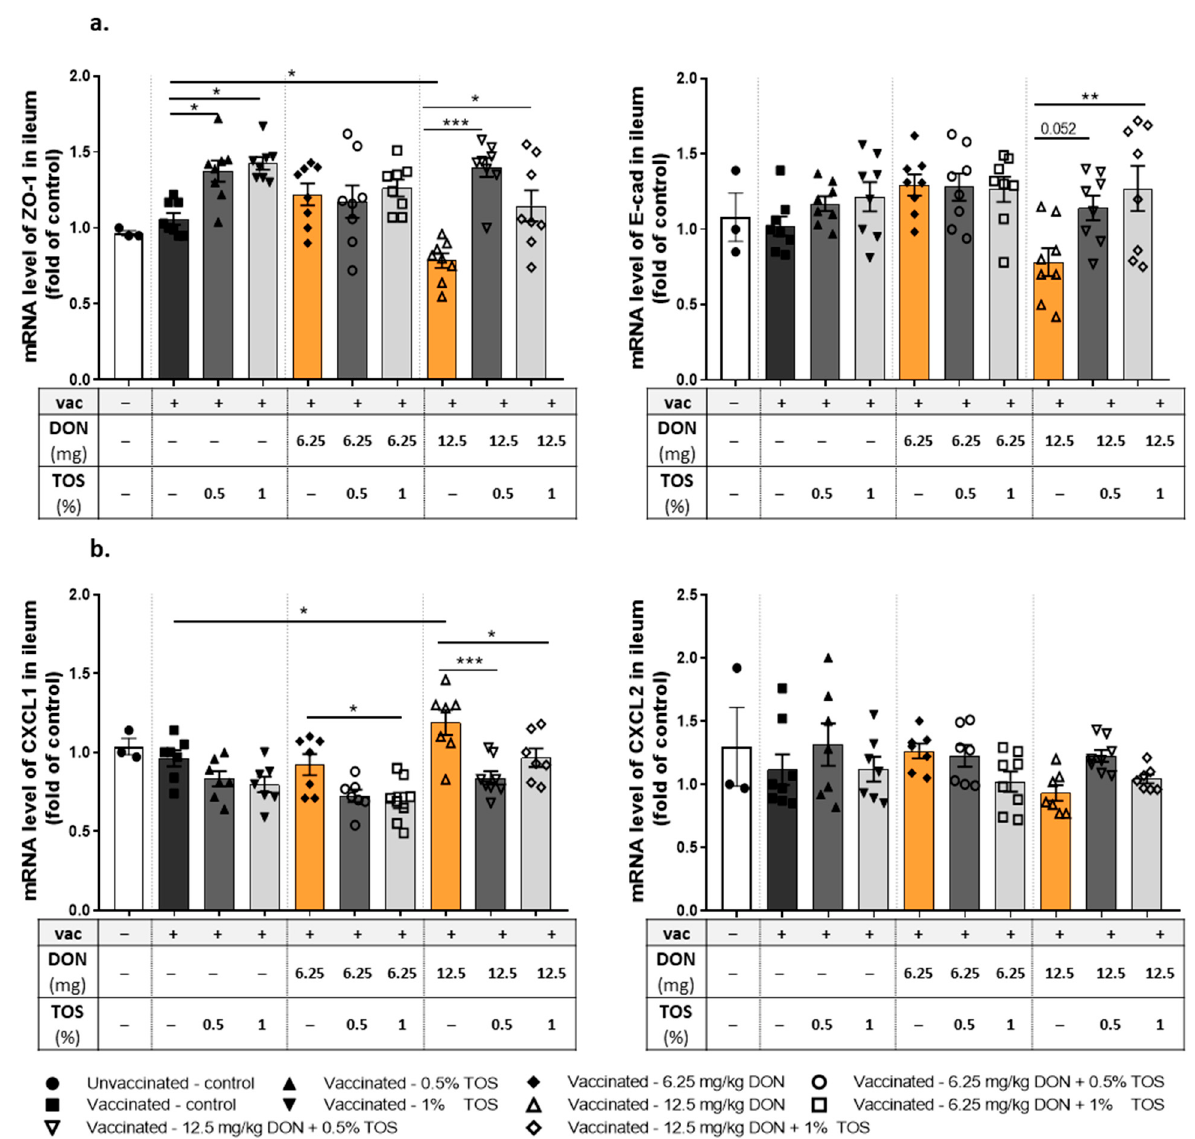
Figure 7. mRNA expression in ileum samples collected from vaccinated (vac +) and unvaccinated (vac − ) mice fed on diets containing deoxynivalenol (DON) and/or trans-galacto-oligosaccharides (TOS). Relative mRNA expression of ( a ) tight junction protein zonula occludens (ZO)-1 and adherent junction protein E-cadherin (E-cad), and ( b ) murine chemokines CXCL2 (or MIP-2) and CXCL1 (or KC). Data are presented as mean ± SEM. * p < 0.05, ** p < 0.01 and *** p < 0.001 indicate statistical differences.